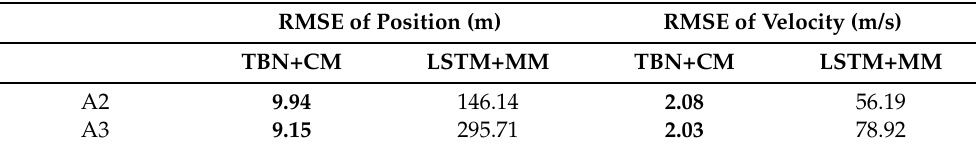
Table 4. Results of tracking trajectories at different initial